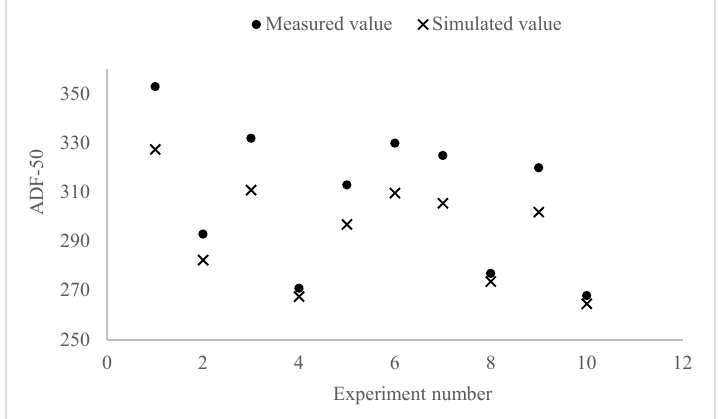
Figure 5. ADF-50 neural network model verification.